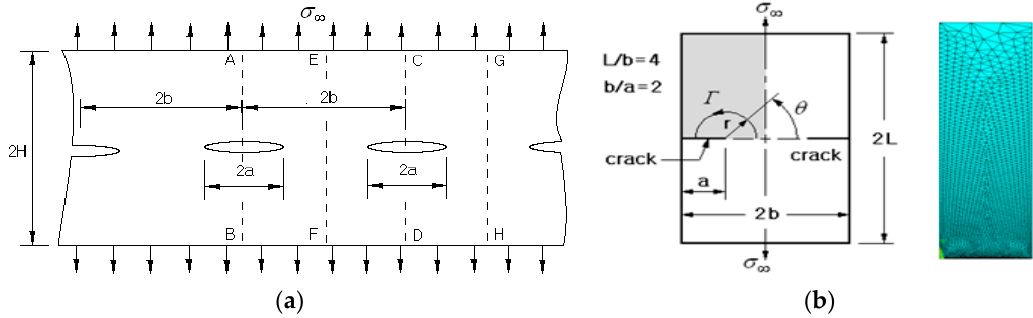
Figure 5. ( a ) Infinite plate with collinear cracks in plane strain state [2], ( b ) periodic model with double edge cracks and a gradient natural element method (NEM) grid (unit: m, N =